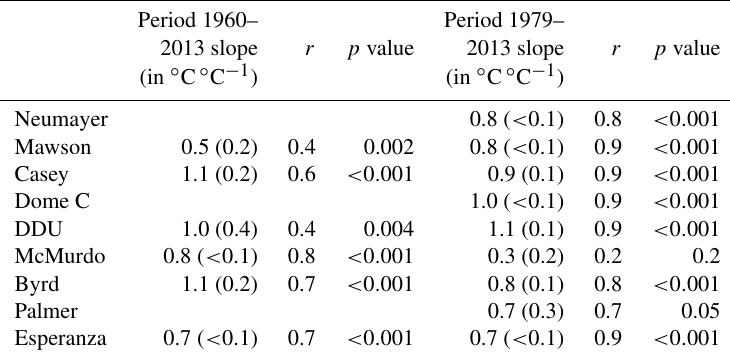
Table 2. Linear relationship between surface temperatures (in ◦ C) from station instrumental records and ECHAM5-wiso outputs (in ◦ C) over the period 1960–2013 and 1979–2013: the slope (in ◦ C ◦ C − 1 ), the correlation coefficient (noted as “ r ”), and the p value. Data are not reported for 1960–2013 for stations for which records only cover the second period (1979–2013). Numbers in brackets correspond to standard